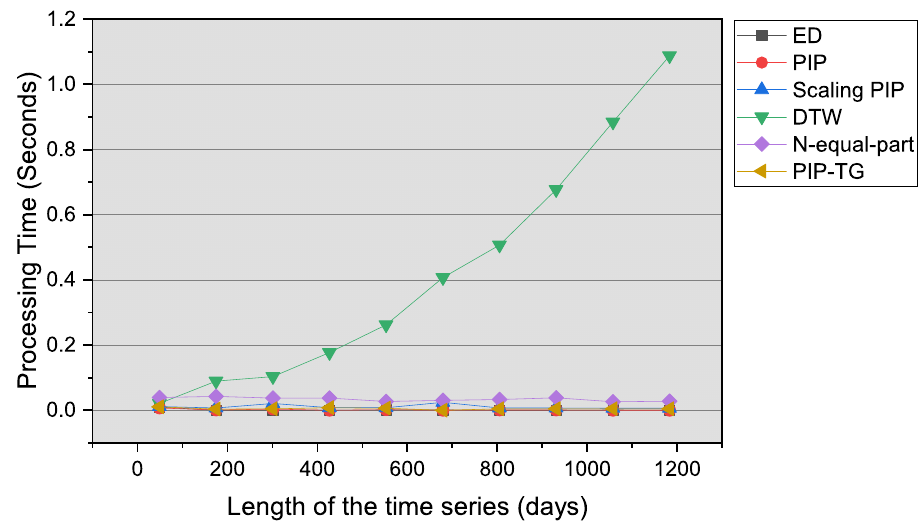
Figure 10. Processing time of each model. Table 3. The accuracy of each template pattern with different standard deviation. ED DTW PIP PIP-TG N-Equal-Part Scaling PIP